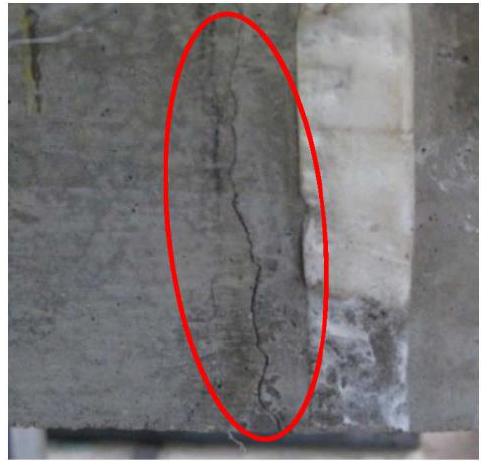
Figure 5. Crack at segmental joints of girders B2 to B4. Table 1. Maximum deformation test values of girder specimens (unit: mm).